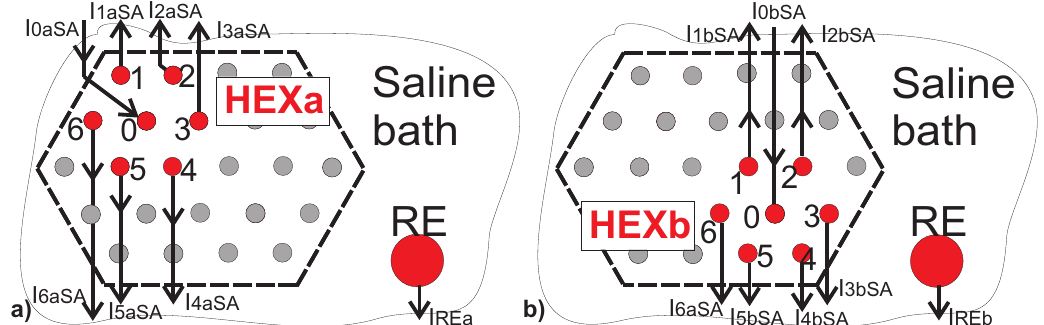
Figure 11. Sketch of Hex Quasi-monopolar (HQ) return stimulation patterns using ( a ) the hexagonal site HEXa operating stand-alone (SA) and the return electrode (RE) or ( b ) the hexagonal site HEXb operating SA and the